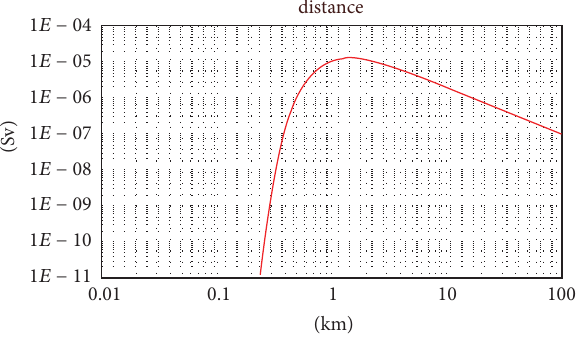
Table 1: SGTR accident source term for AP1000.